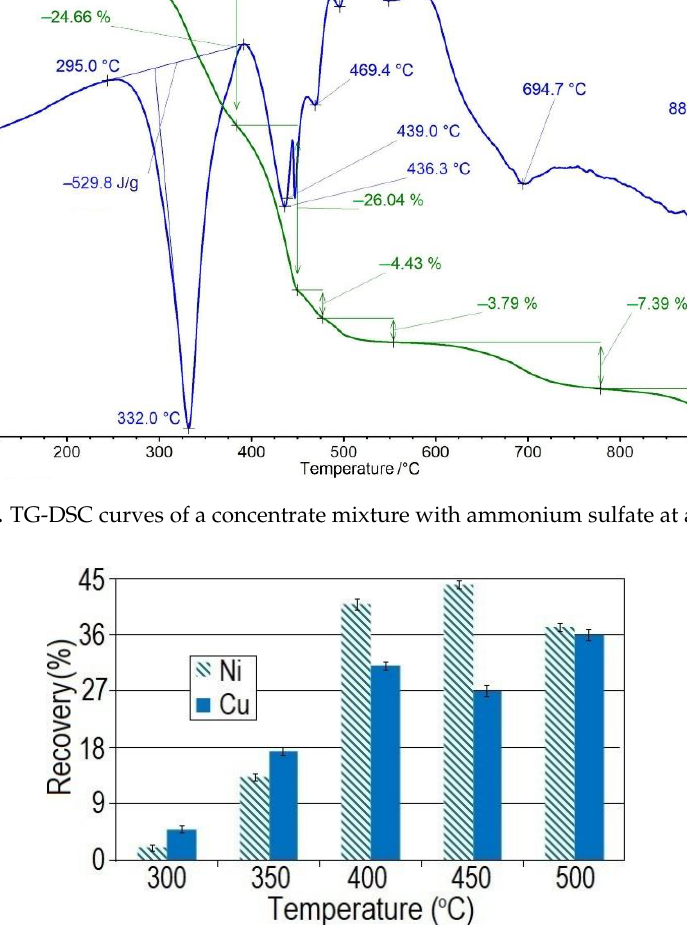
Figure 7. TG-DSC curves of a concentrate mixture with ammonium sulfate at a ratio of 1:2.